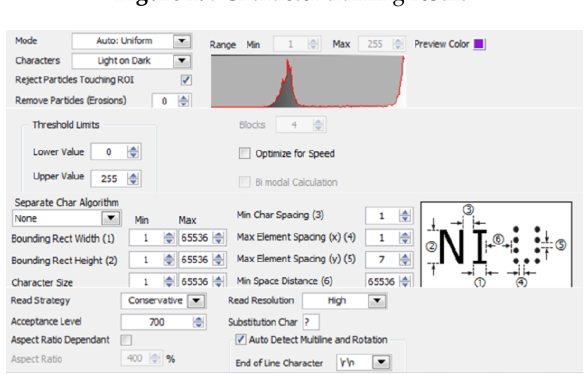
Figure 18. Character training interface. Figure 19. Character training result.